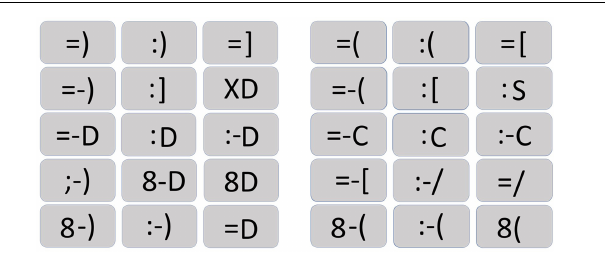
FIGURE 1 | Typographic emoticons set. The 15 positive emoticons used on the experiment are on the left side of the figure, and the 15 negative emoticons are on the right